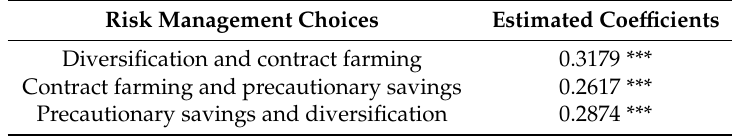
Table 2. Correlation coe ffi cients estimates in di ff erent pairs of risk management